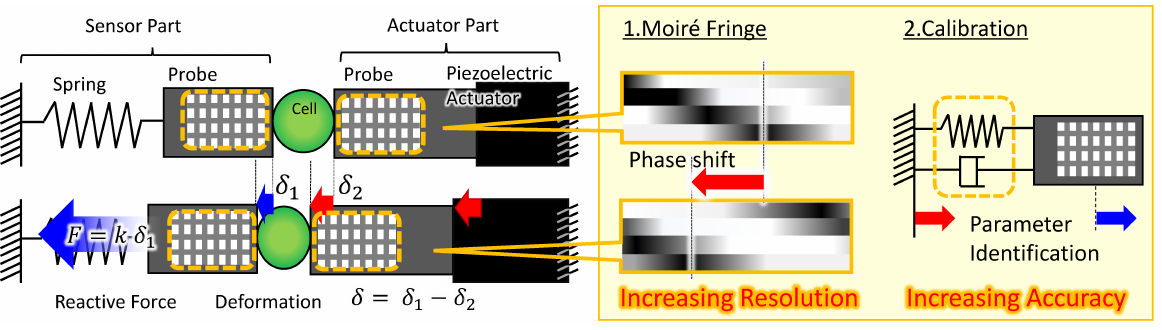
Figure 3. Components for the measurement and proposed method to improve the sensing